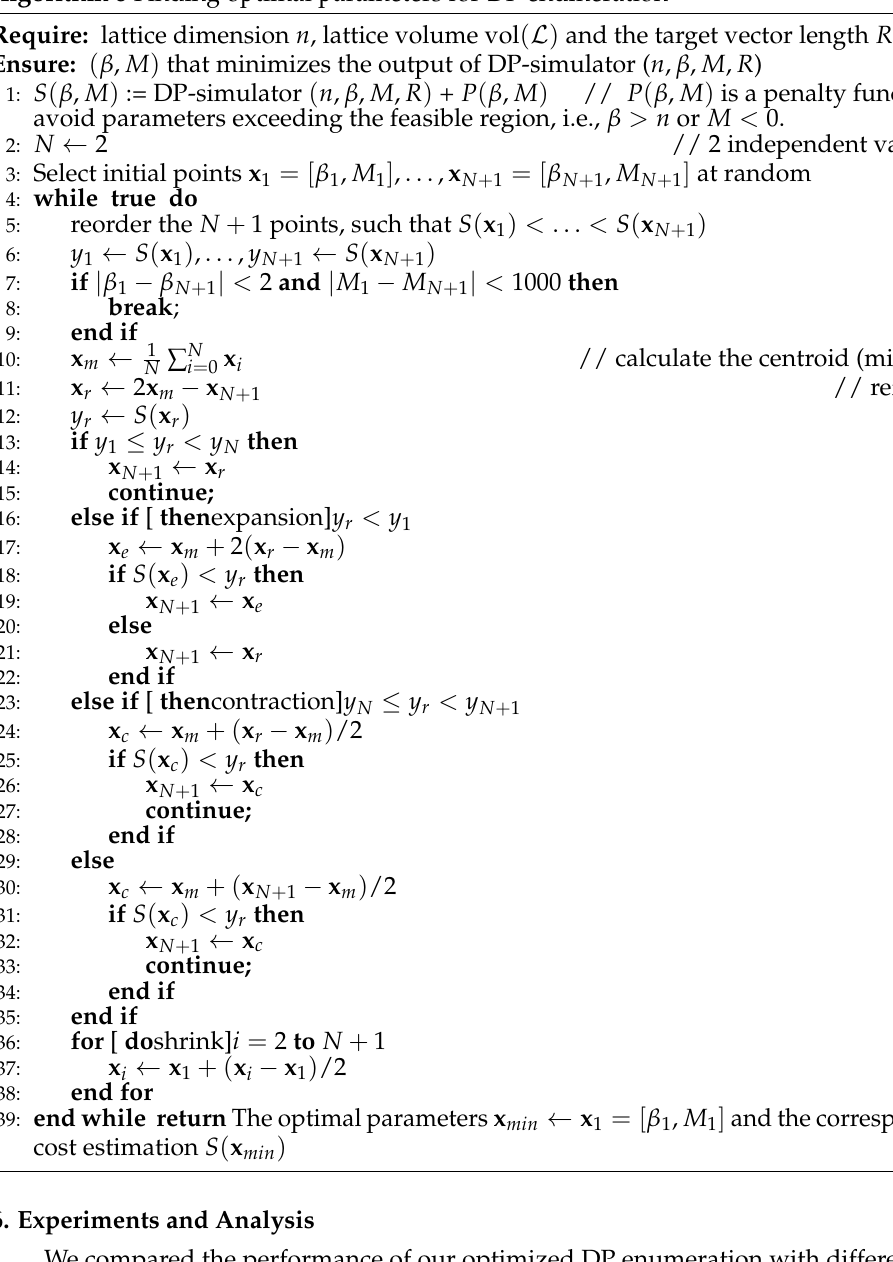
Algorithm 8 Finding optimal parameters for DP